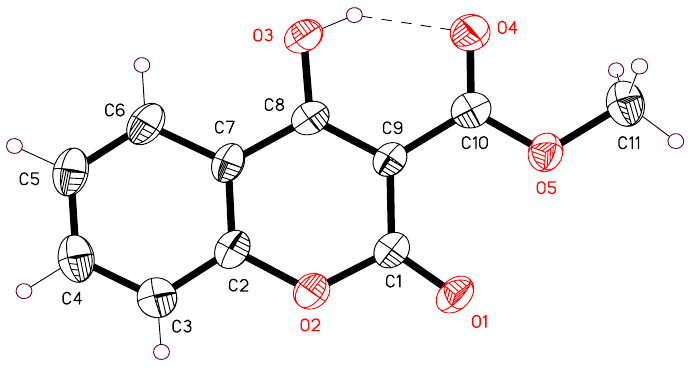
Figure 4. X-ray structure and numbering scheme of compound 4a .